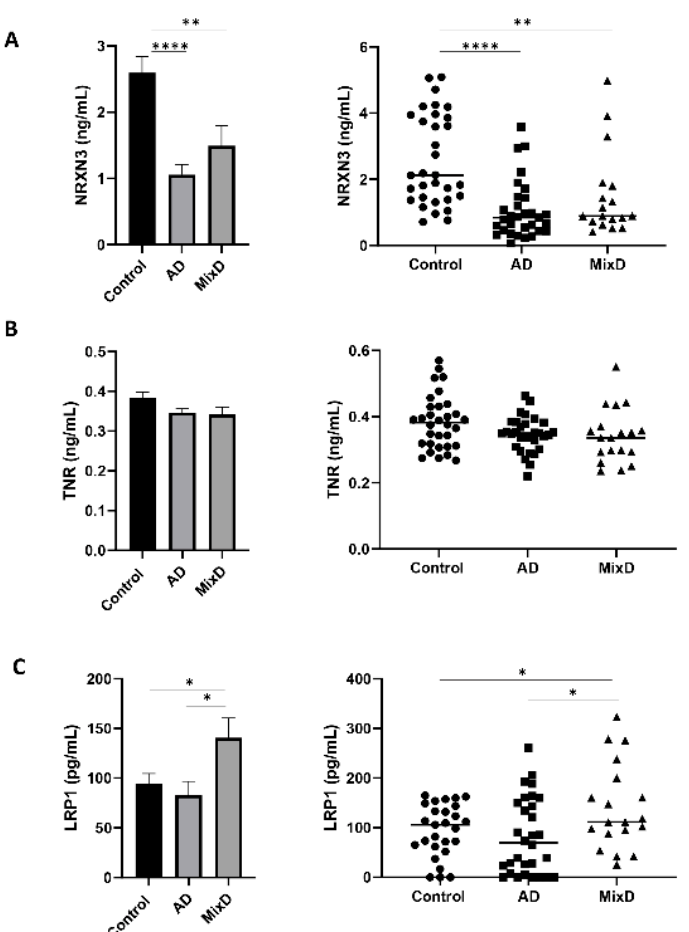
Figure 7. Monitoring of NRXN3 ( A ), TNR ( B ), and LRP1 ( C ) protein levels across serum samples from AD and MixD subjects. Protein levels were measured in sera derived from 82 individuals (30 controls; mean age: 70 years; 15 F/15 M), 30 patients with AD: mean age 75 years, 15 F/15 M, and 19 patients with MixD: mean age 79 years; 10 F/9 M). * p < 0.05; ** p < 0.01; **** p < 0.0001.